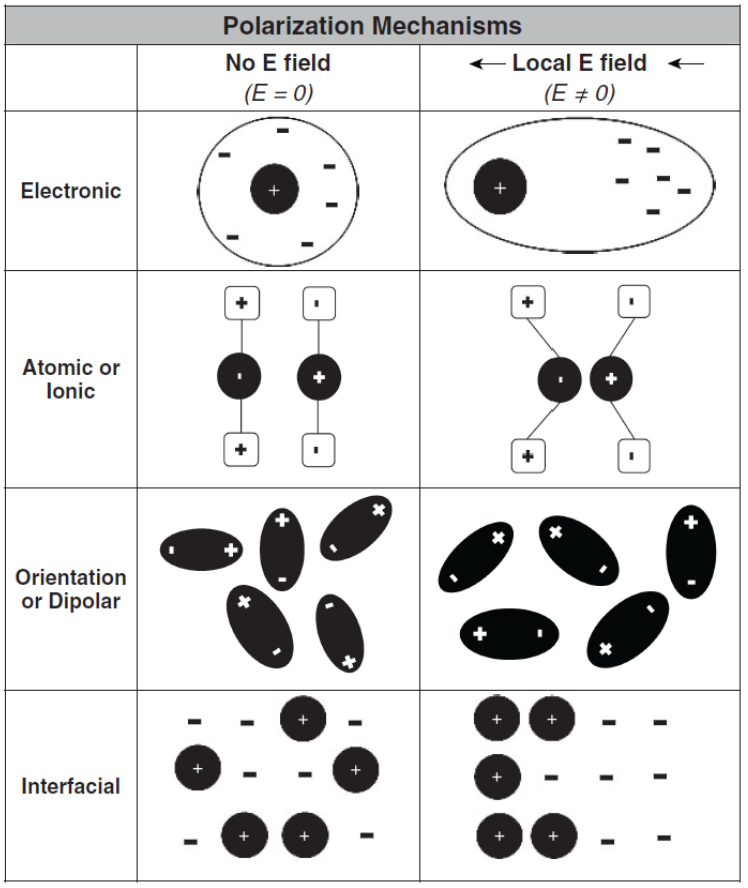
Figure 1. Polarization mechanisms. Reprinted with permission from Ref. [44] (p. 36). Copyright 2007 John Wiley & Sons.